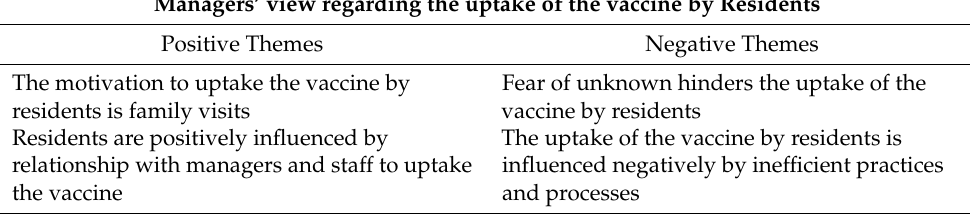
Table 8. Summary of identified themes regarding the uptake of the vaccine by residents and staff, and the impact of social